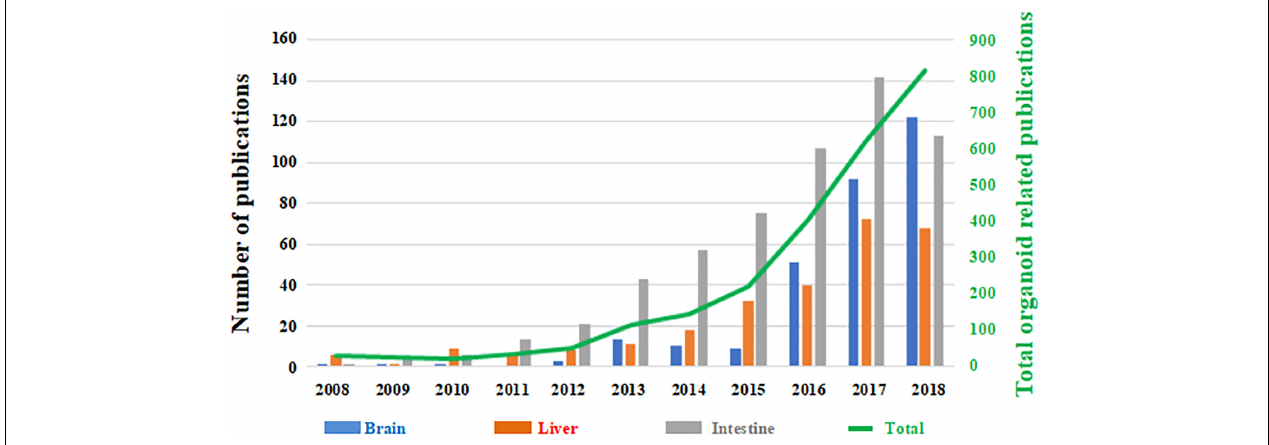
FIGURE 1 | Number of papers published on organoid technology since 2008. The number of papers focused on brain organoids (blue) are shown as a function the total number of published works based on this technology (green trend line, right hand secondary axis). Papers focused on liver (red) and intestinal (gray) organoids are shown for comparison. (Source: PubMed).